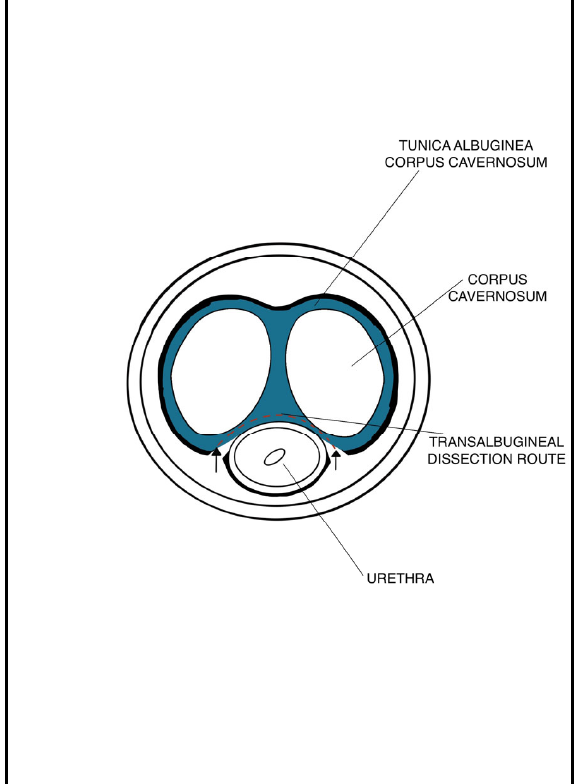
Figure 4. Transversal view of transalbugineal dissection.